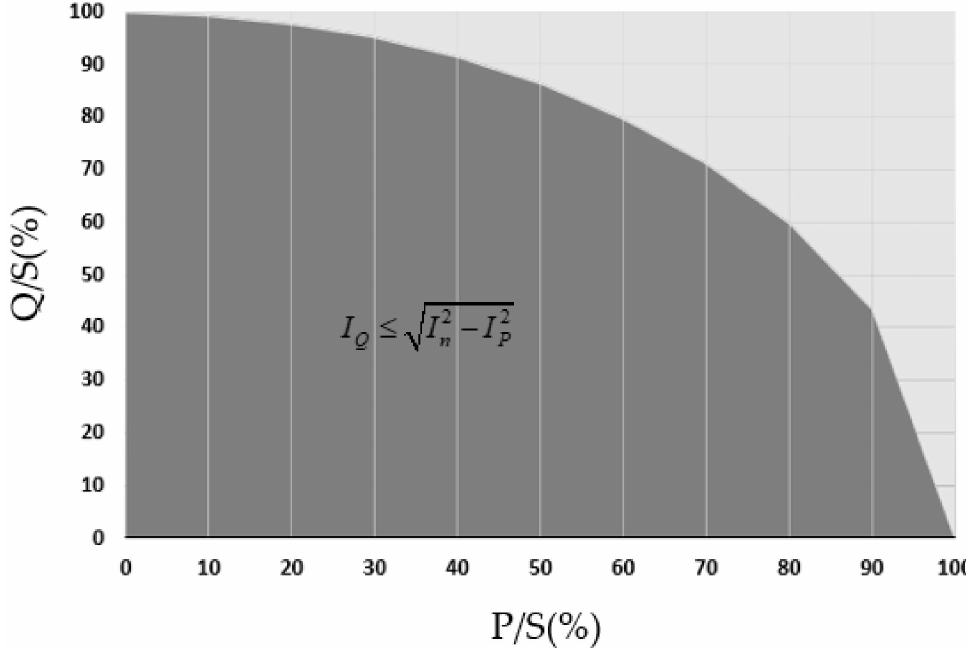
Figure 1. Reactive current generation capability as a function of active power: reactive power related to apparent power Q/S in % vs. active power related to apparent power P/S in %.